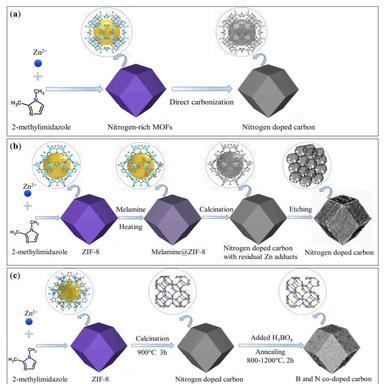
Synthesis schematic of MOFs derived non-metallic heteroatom-doped CMs (a) In situ doping: direct pyrolysis of Nitrogen-rich MOFs (b) In situ doping: Copyrolysis of MOFs and nitrogen-rich precursors (c) Post doping: N, B co-doped MOFs-derived carbon.